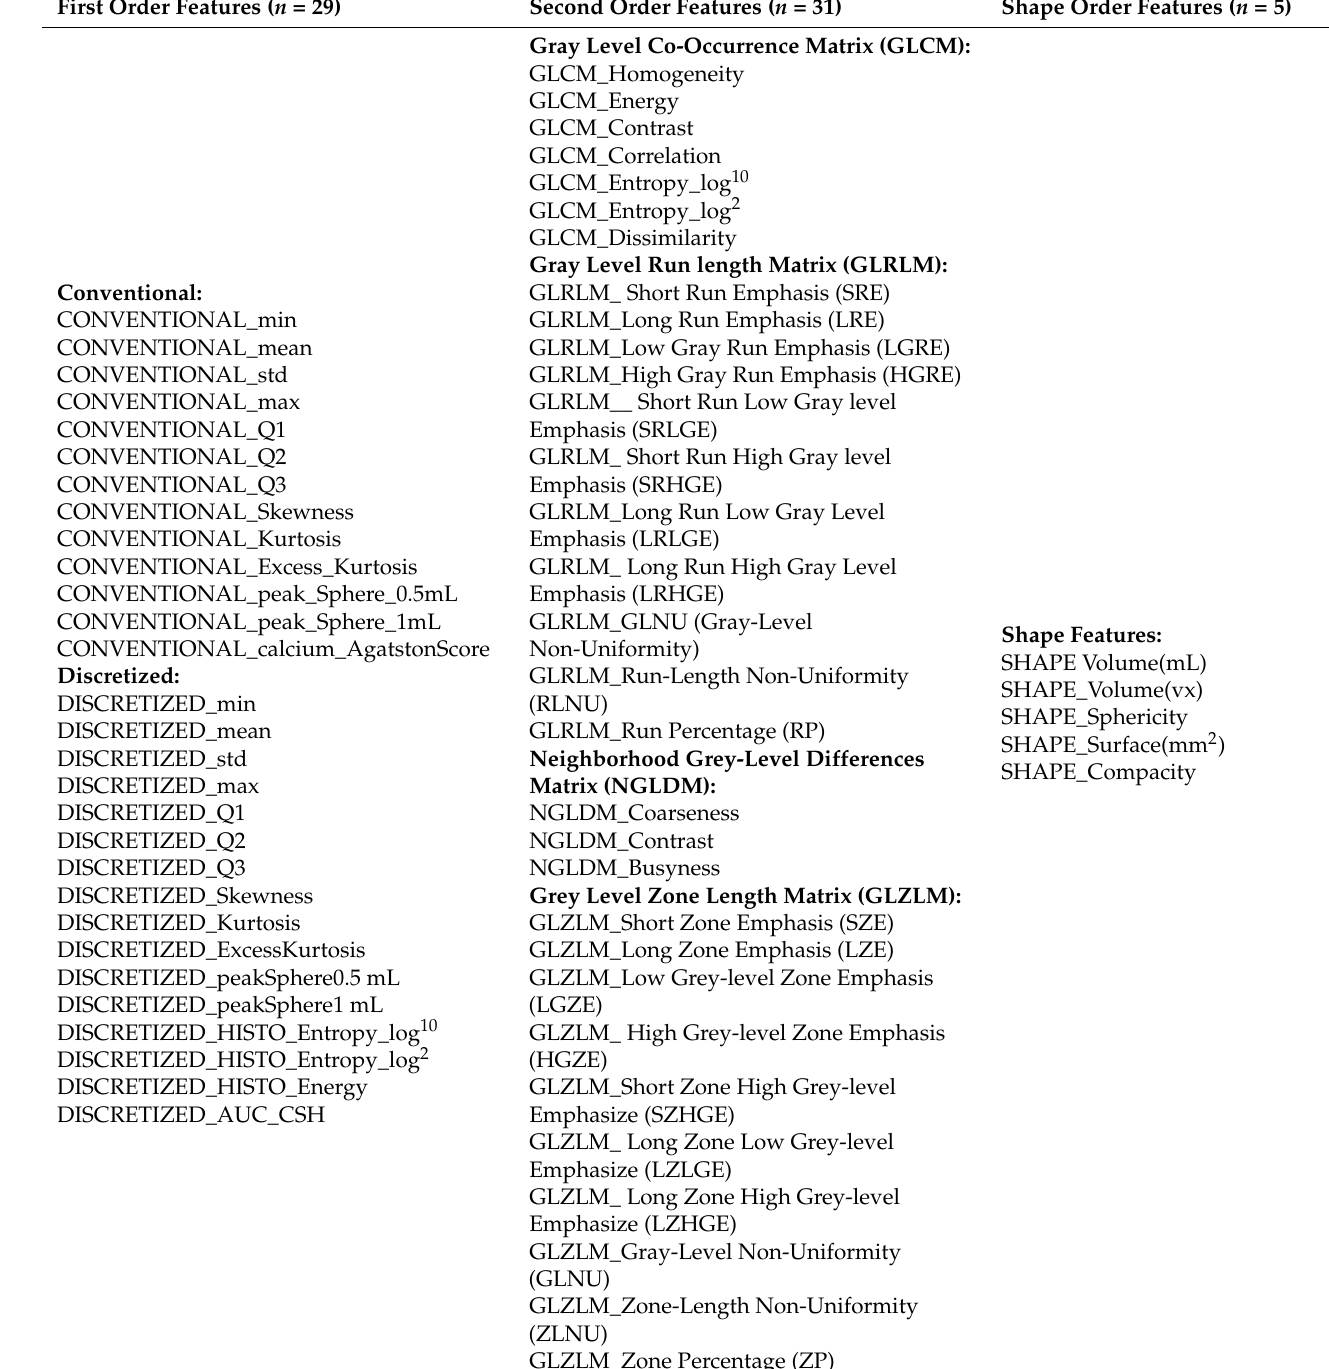
Table 2. First order features ( n = 29), second order features ( n = 31), and shape order features ( n = 5) are extensive descriptions of radiomic features collected from each divided